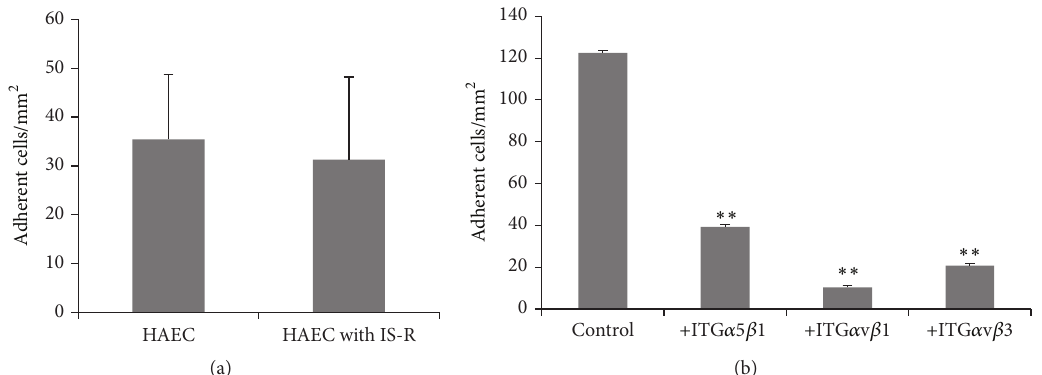
Figure 7: The influence of fibronectin on the dynamic interaction of LO-EPC with control HAEC and HAEC with ischaemia reperfusion injuryunder0.7 dyn/cm 2 shearstress.3 × 10 4 HAECwereplatedintoIbidi 𝜇 -SlideVI0.4Luerslideswhichhadbeenprecoatedwith100 𝜇 g/mL fibronectin. The data represent a mean ± SE of three experiments. LO-EPC adhesion to fibronectin was integrin dependent (b). LO-EPC binding to fibronectin was blocked by antibodies against integrin 𝛼 5 𝛽 1, integrin 𝛼 v 𝛽 1, and integrin 𝛼 v 𝛽 3. The data represent the mean ± SE of three experiments. ∗∗ 𝑝 < 0.01 compared to the control (no blocking